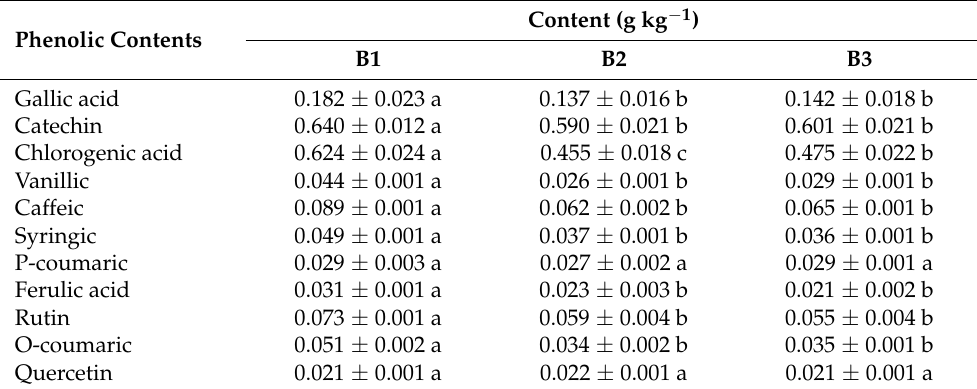
Table 2. Phenolic compounds detected in berberis